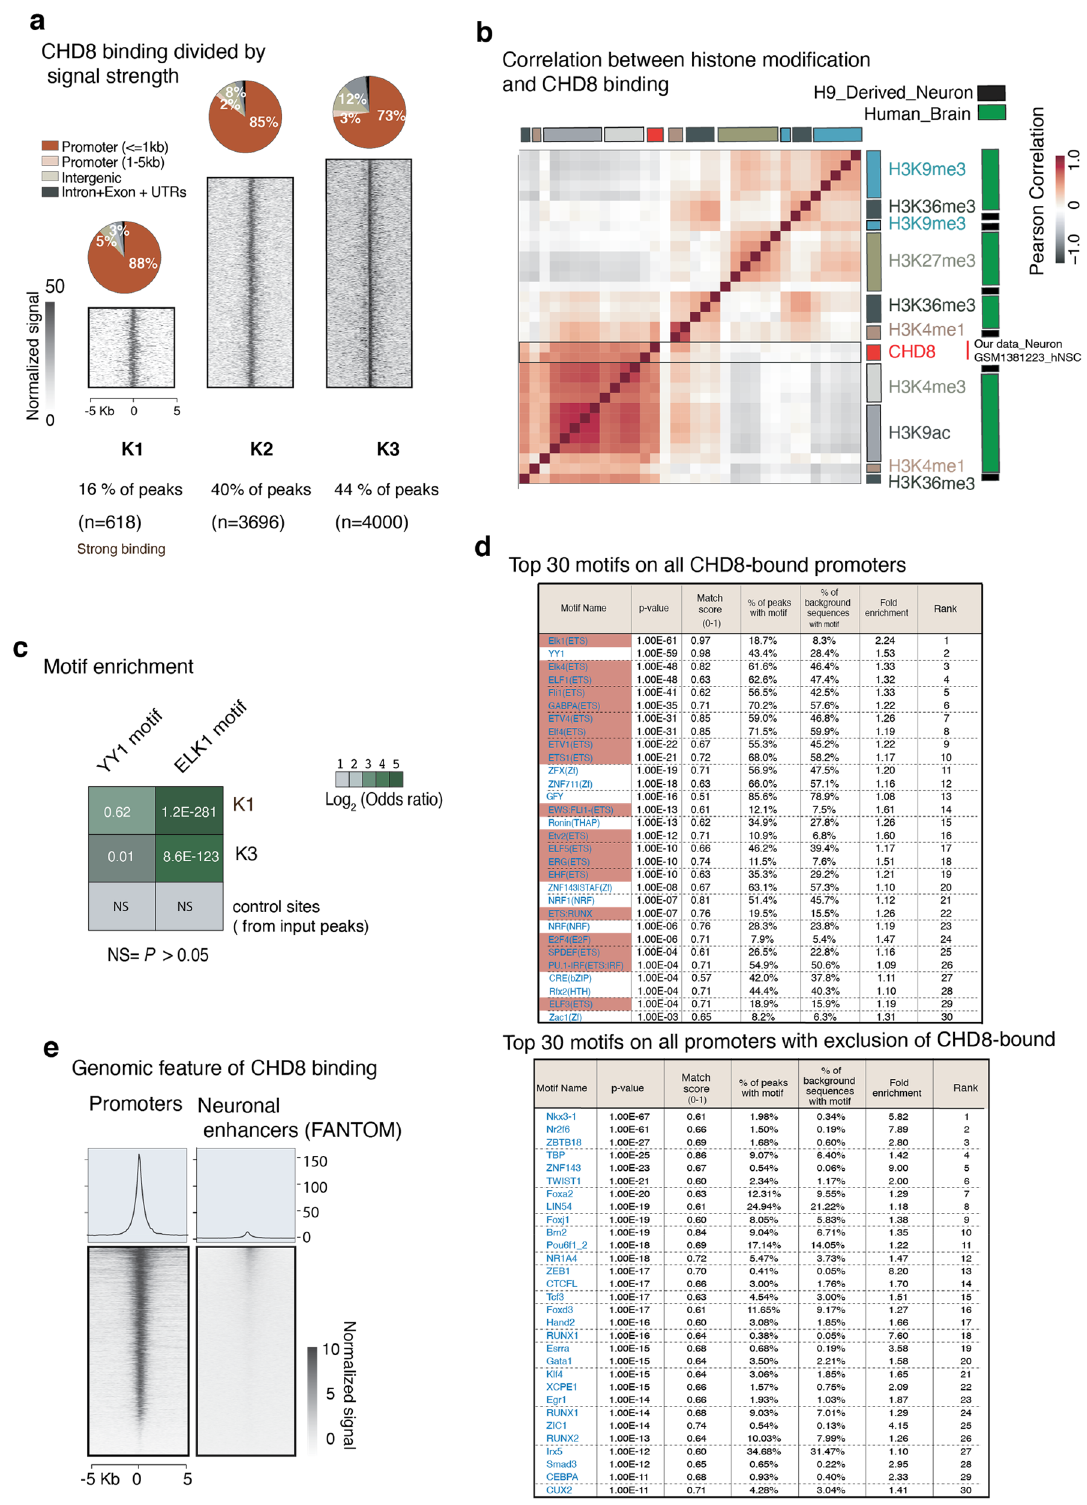
Figure 12. CHD8 binding and enrichment at chromatin regions with distinct histone modification in neurons. ( a ) K-means clustering ChIP-seq signal into three groups recognize the most specific targets of CHD8 binding at promoters. Genomic annotation and functional classification are separately assigned for each group. ( b ) Pearson`s correlation of histone modification obtained from H9 derived human neurons (ENCODE`s histone ChIP-seq data) and our CHD8 ChIP-seq signal at CHD8 binding sites (K1 + K2 + K3). ( c ) The odds ratio and the calculations of motif enrichment at strong CHD8 binding sites (K1), the weak binding sites (K3), and the control sites (randomly shuffled peaks from input). Sites (K1, K2, and K3) taken from clustering analysis of peaks among CHD8 binding sites-the top heatmap Fig. 13b). ( d ) Top 30 motifs enriched at the prompters (± 5 Kb) of 3000 CHD8-bound target genes. The ETS factor motifs are highlighted in red. ( e ) Heatmap of CHD8 binding signal at promoters of neural genes and enhancers (FANTOM database) 45